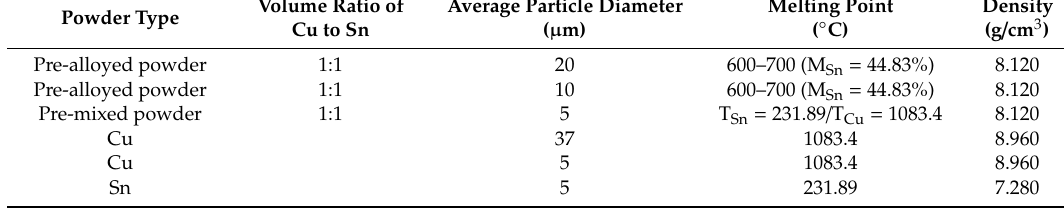
Table 1. Types and properties of powders.